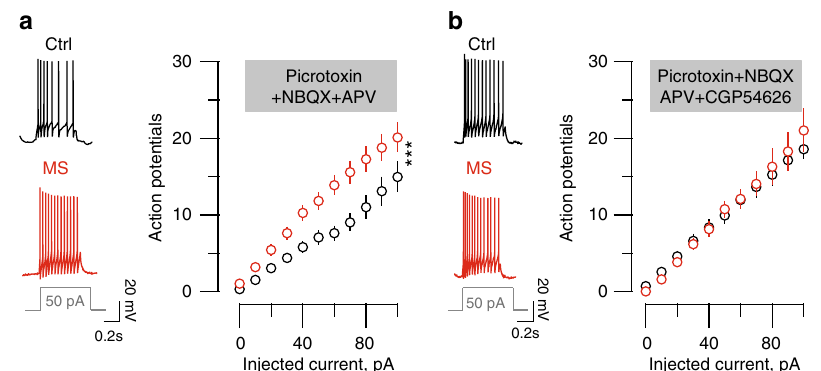
Fig. 3 MS-induced LHb neurons hyperexcitability requires reduced GABA B -GIRK signaling. a Left, sample traces for recordings in Ctrl and MS mice of a current-evoked fi ring (for a 50 pA step) in the presence of picrotoxin/NBQX. Graph representing the action potentials vs. injected current in all experimental groups. (picrotoxin/NBQX, n mice = 4/6; n cells = 20 per group; two-way ANOVA-RM, interaction F (10;380) = 3.52; *** p < 0.001) b Same than a but in the presence of picrotoxin/NBQX/CGP54626, n mice = 5/6; n cells = 20 per group; two-way ANOVA-RM, interaction F (10;380) = 0.32). Scale bars =